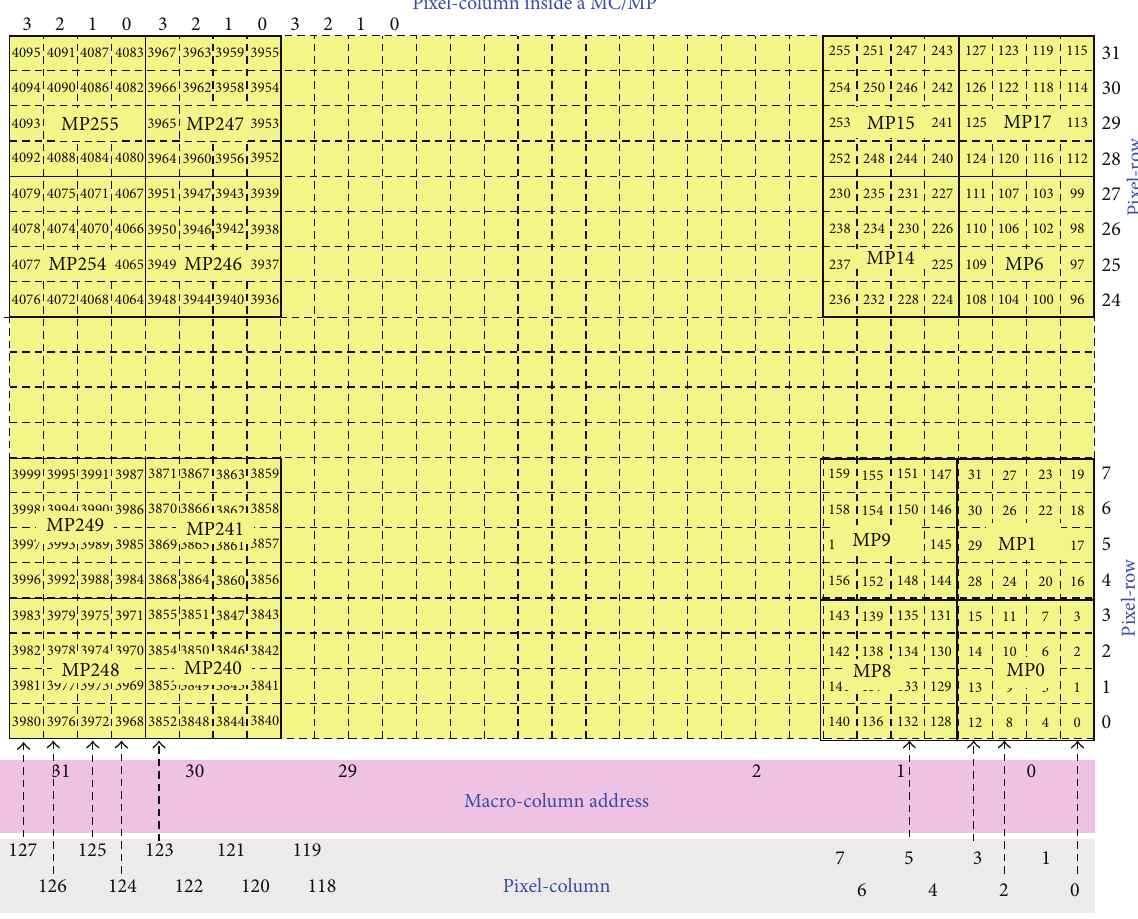
Figure 27: 4096-pixel matrix.